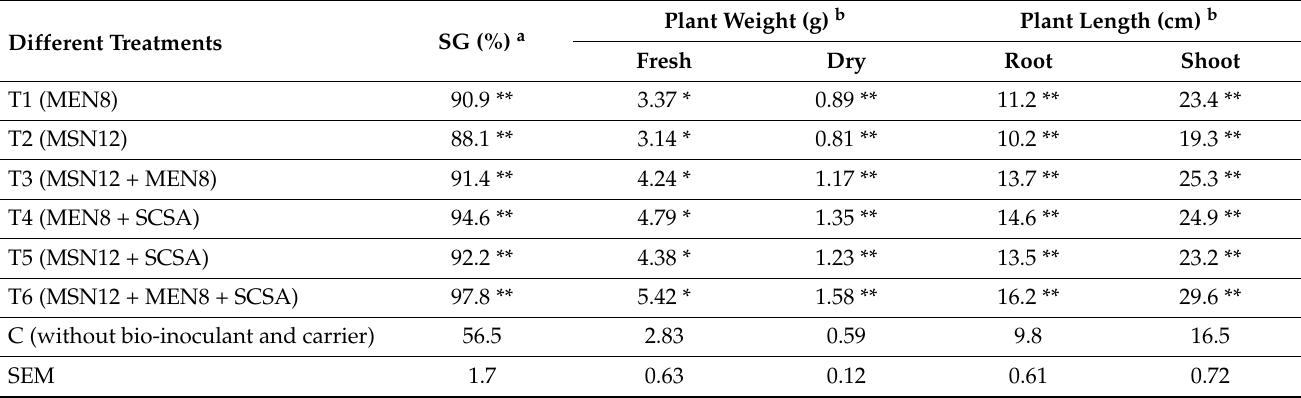
Table 2. Effects of different treatments on seed germination and vegetative parameters of chickpea during field assessment (mean value of two years 2016–2017 and